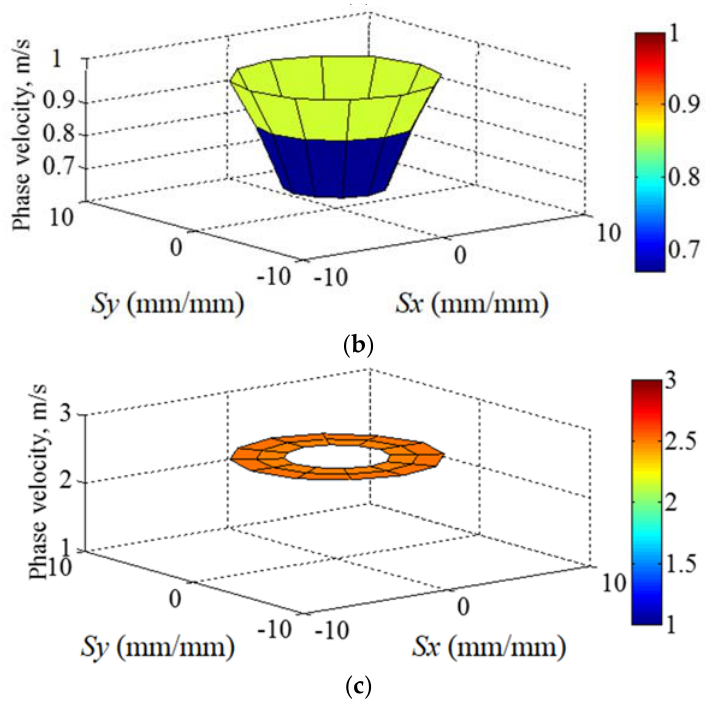
Figure 4. Designed variation in wave phase velocity (relative to background) inside the cloak shell: ( a ) in the e u direction of the cloak shell region; ( b ) in the e v direction; ( c ) in the e w direction. The direction of incoming waves can be guided by altering the wave phase speed using the anisotropic material properties of the cloak shell.